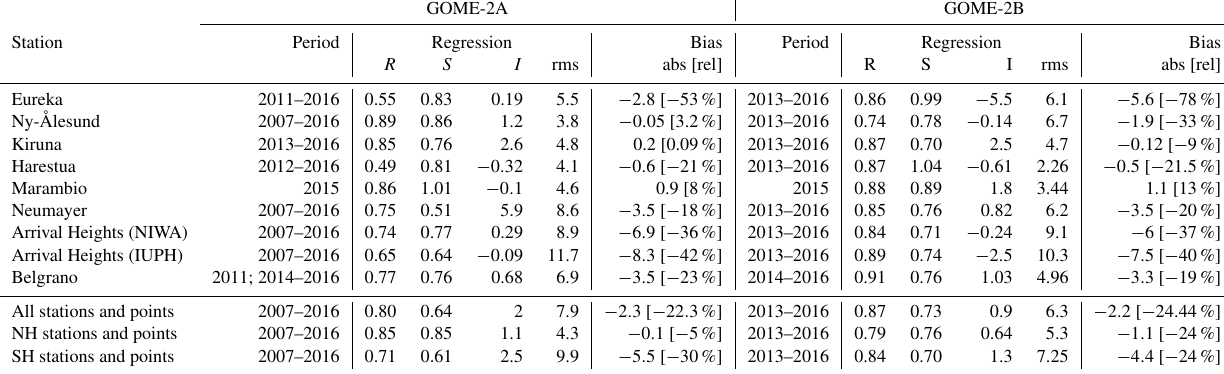
in the Arctic and Antarctic regions: Eureka (80 ◦ N),